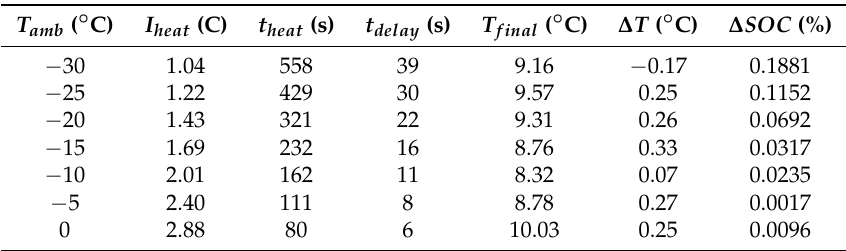
Figure 13. ( a ) Differences in temperature between layers at the end of pre-heating with ( ∆ T 1 ) and without ( ∆ T 2 ) the insertion of the idle period. ( b ) SOC difference between the layers and total SOC losses at the end of pre-heating by using the proposed method. Table 2. Recommended charging profiles to 10 ◦ C with respect to T amb